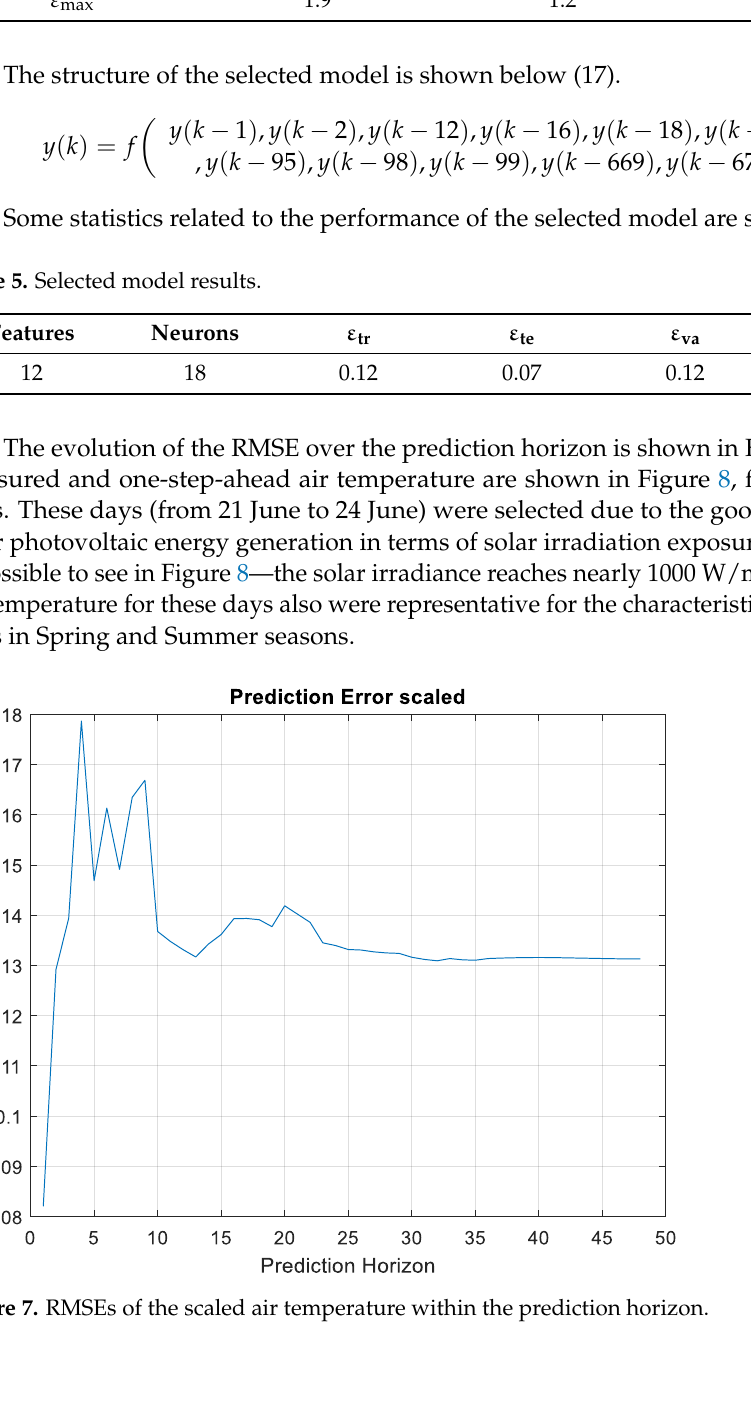
Figure 8. Measured (blue) and one-step-ahead forecast (red) solar irradiance for four selected days. 4.2.2. Air Temperature Model The same 38 lags were considered for this model. No duplicate samples were found, and therefore 6310 samples were available for model design. AproxHull found 669 convex